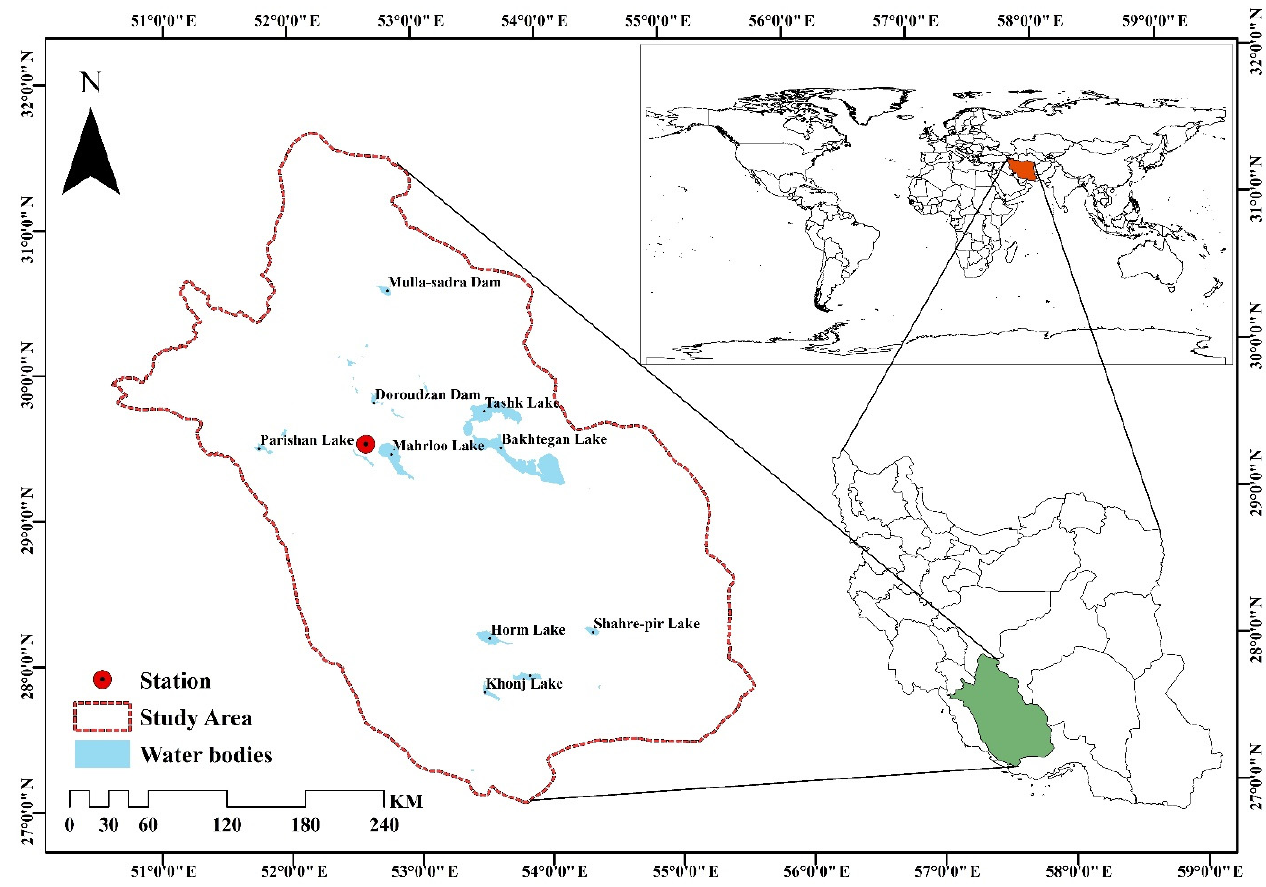
Figure 1. The study area and location of Shiraz synoptic stations. In this research, the Shiraz synoptic station is selected for evaporation modeling, which has a moderate semi-arid climate based on the Extended De-Martonne classification. The statistical characteristics of the data used are listed in Table 1 which covers daily data from 2006 to 2021. These data include 16 variables; maximum air temperature (Tmax), minimum air temperature (Tmin), mean air temperature (T), dew point temperature (Tdew), wet-bulb temperature (Twet), the maximum air pressure (Fmax), minimum air pressure (Fmin), mean air pressure (F), maximum relative humidity (RHmax), minimum relative humidity (RHmin), mean relative humidity (RH), relative humidity at 03:00 (RH03), relative humidity at 09:00 (RH09), relative humidity at 15:00:00 (RH15) and pan evaporation (Epan). Since the recorded data of solar radiation in most stations of Iran have low quality and a large number of outliers, the present research intends to present a model far from solar radiation. Table 1. Details of the daily datasets of the Shiraz site are obtained from the Iranian Meteorological Organization.